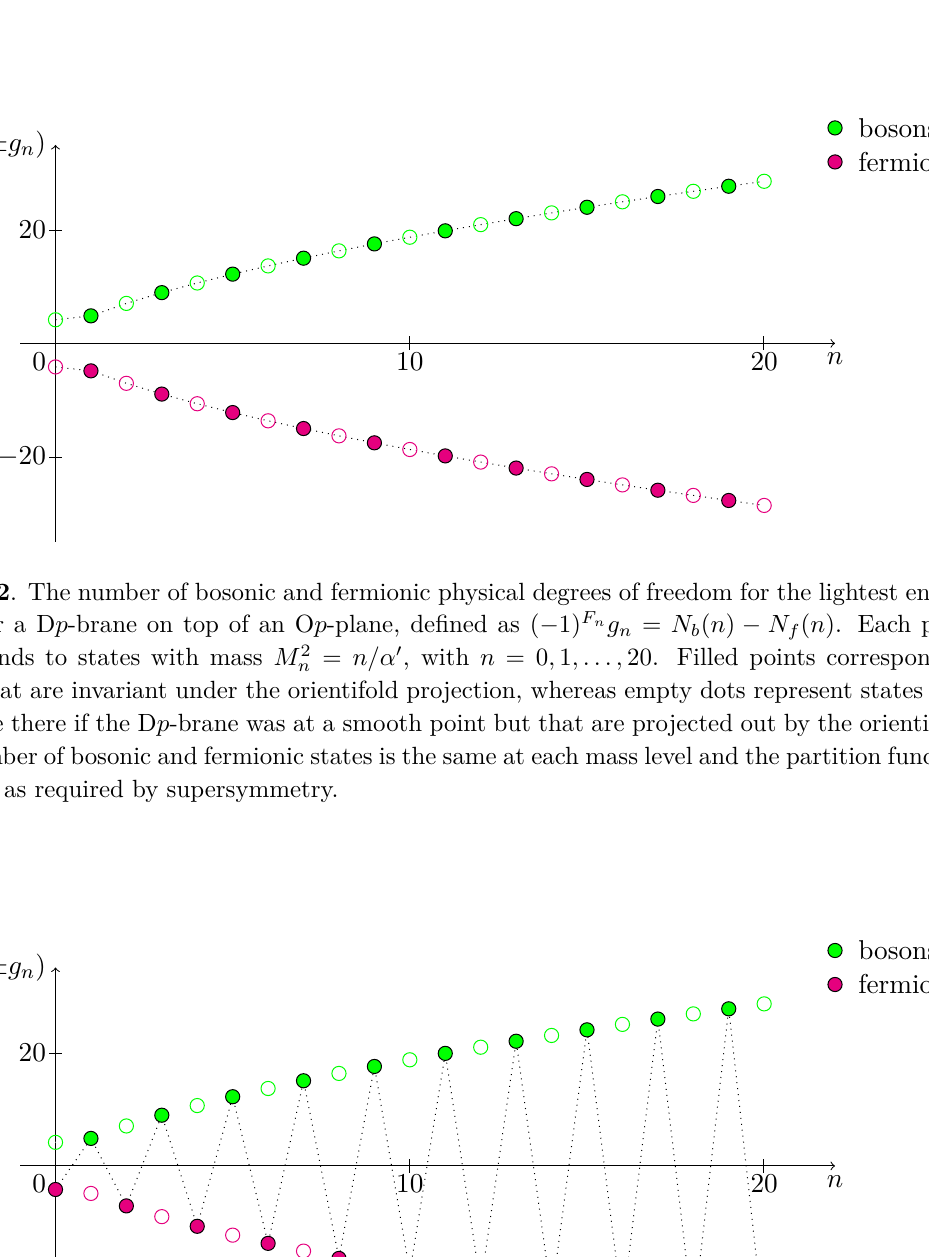
= N ( n ) − N ( n ) . Each n b f = n/α 0 , with n = 0 , 1 , . . . , 20 . Filled points correspond n